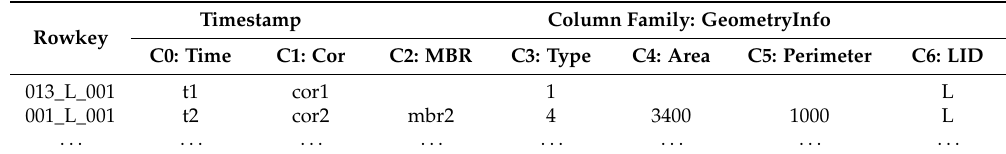
Table 1. Table structure of vector data. Cor, coordinate; LID, layer